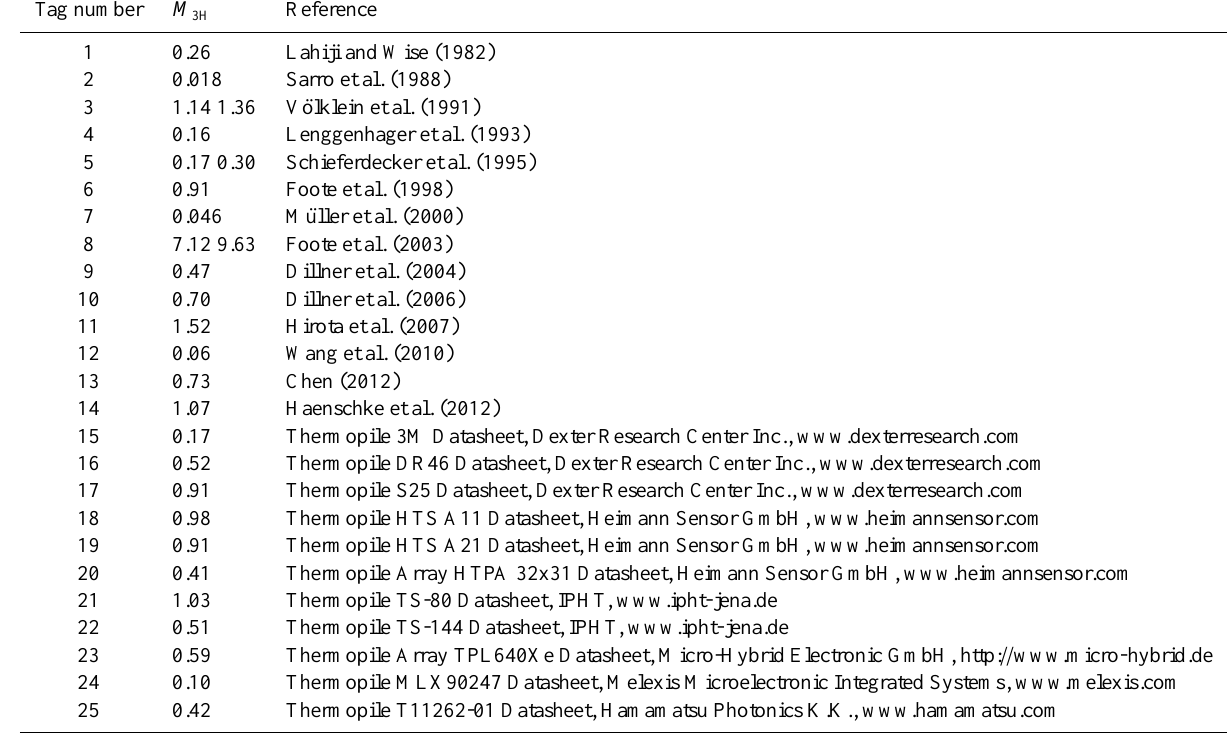
Table 3. Dimensionless figure of merit M 3H and references of the tag numbers of the thermoelectric radiation sensors, cf. Figs. 3 and